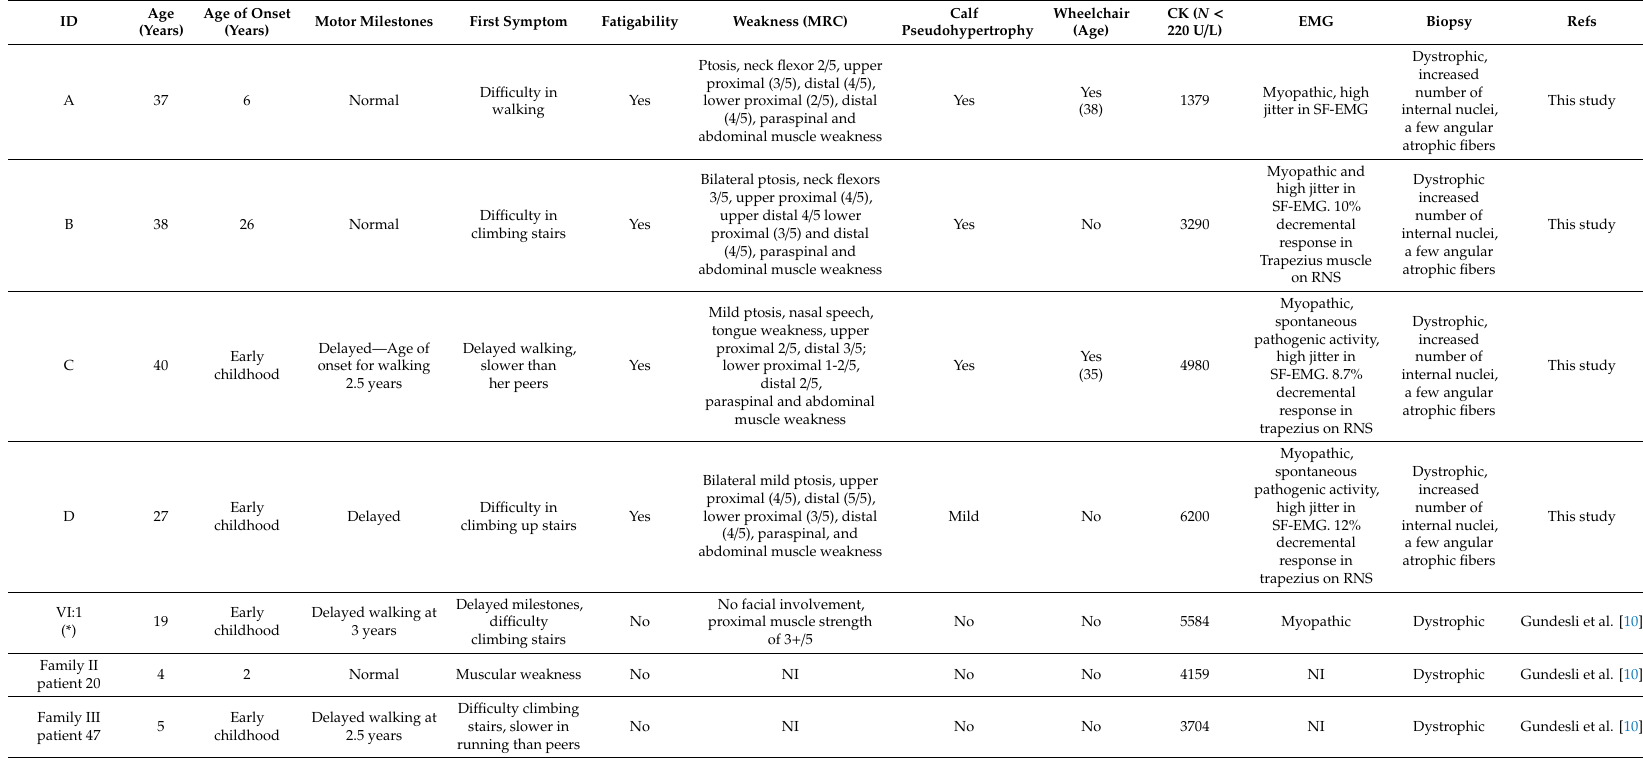
Table 1. Comparison of clinical phenotypes between patients with c.1_9del PLEC